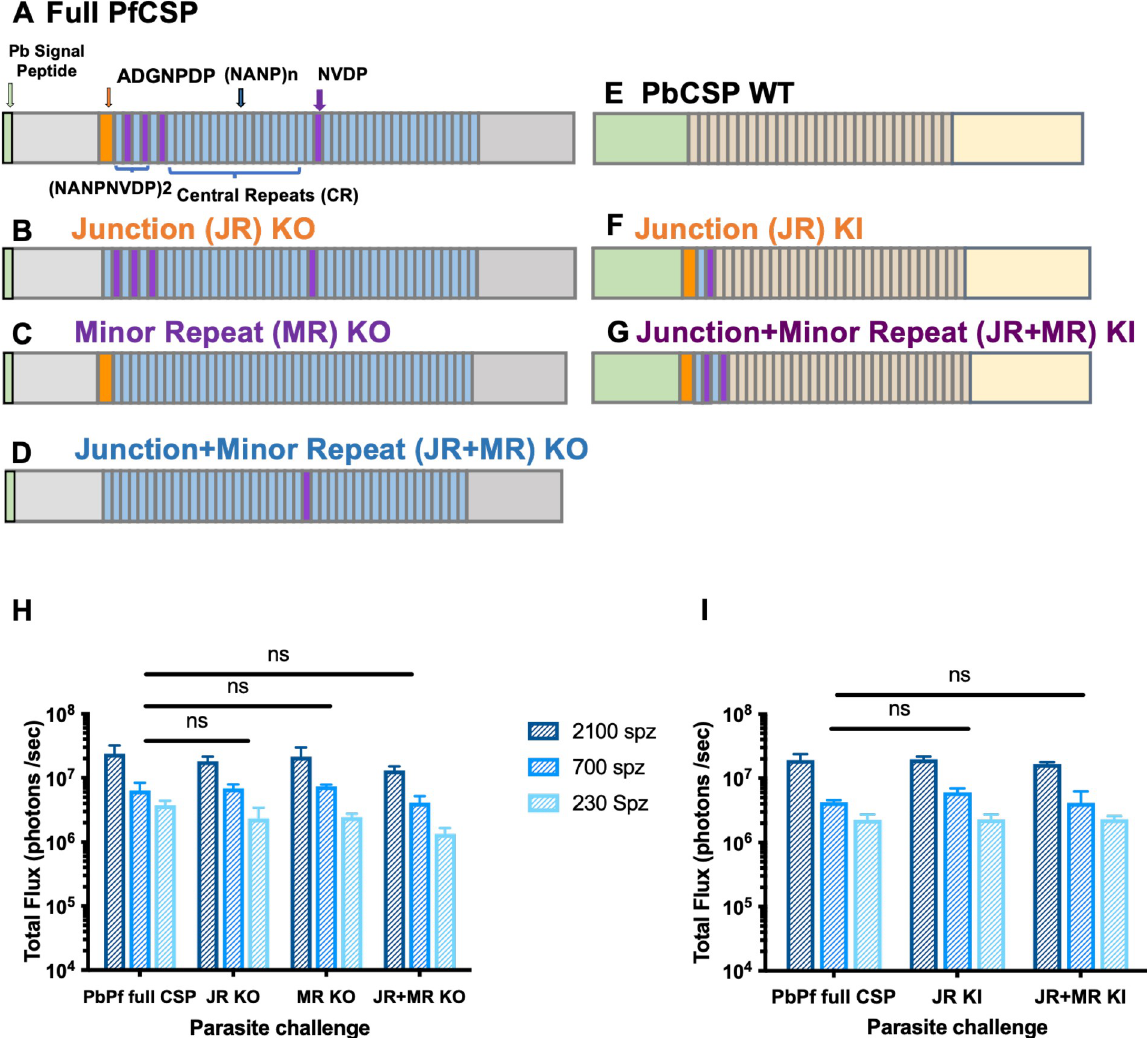
Fig 1. Schematics of CSP versions expressed by Pb transgenic parasite lines and their infectivity in mice. (A) Pb expressing full-length PfCSP (PbPf full CSP). The Pb signal peptide (green), PfCSP N- and C-termini (grey), junction region ADGNPDP (JR, orange), 4 NVDP minor repeats (MR, purple), and 38 central major repeats (CR, blue) are indicated. (B) Pb expressing PfCSP with ADGNPDP deleted (JR KO). (C) Pb expressing PfCSP where the 4 NVDP were changed to NANP (MR KO). (D) Pb expressing PfCSP with ADGNPDP deleted and 3 of the 4 NVDP changed to NANP (JR+MR KO). (E) Pb expressing wild-type PbCSP. The N-terminus (green), repeat region (grey), and C-terminus (yellow) are depicted. (F) Pb expressing PbCSP containing the PfCSP JR sequence ADGNPDPNANPNVDP (JR KI). (G) Pb expressing PbCSP containing the PfCSP JR and MR sequences ADGNPDPNANPNVDPNANPNVDP (JR+MR KI). (H-I) Infectivity of the different transgenic parasite lines depicted in A-G, evaluated by challenging C57BL/6 mice with indicated amounts of SPZ and measuring parasite bioluminescence (total